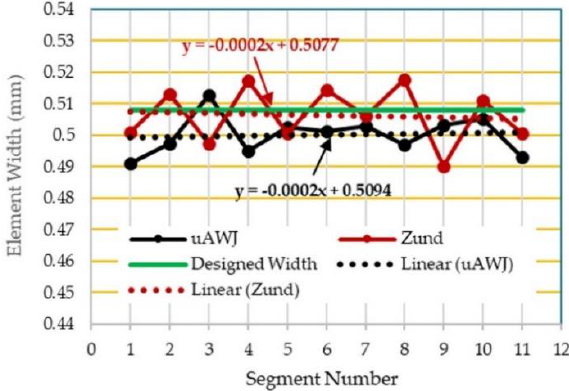
Figure 20. Comparison of average element widths of flexures cut with µ AWJ (U-U mode) and Zund.